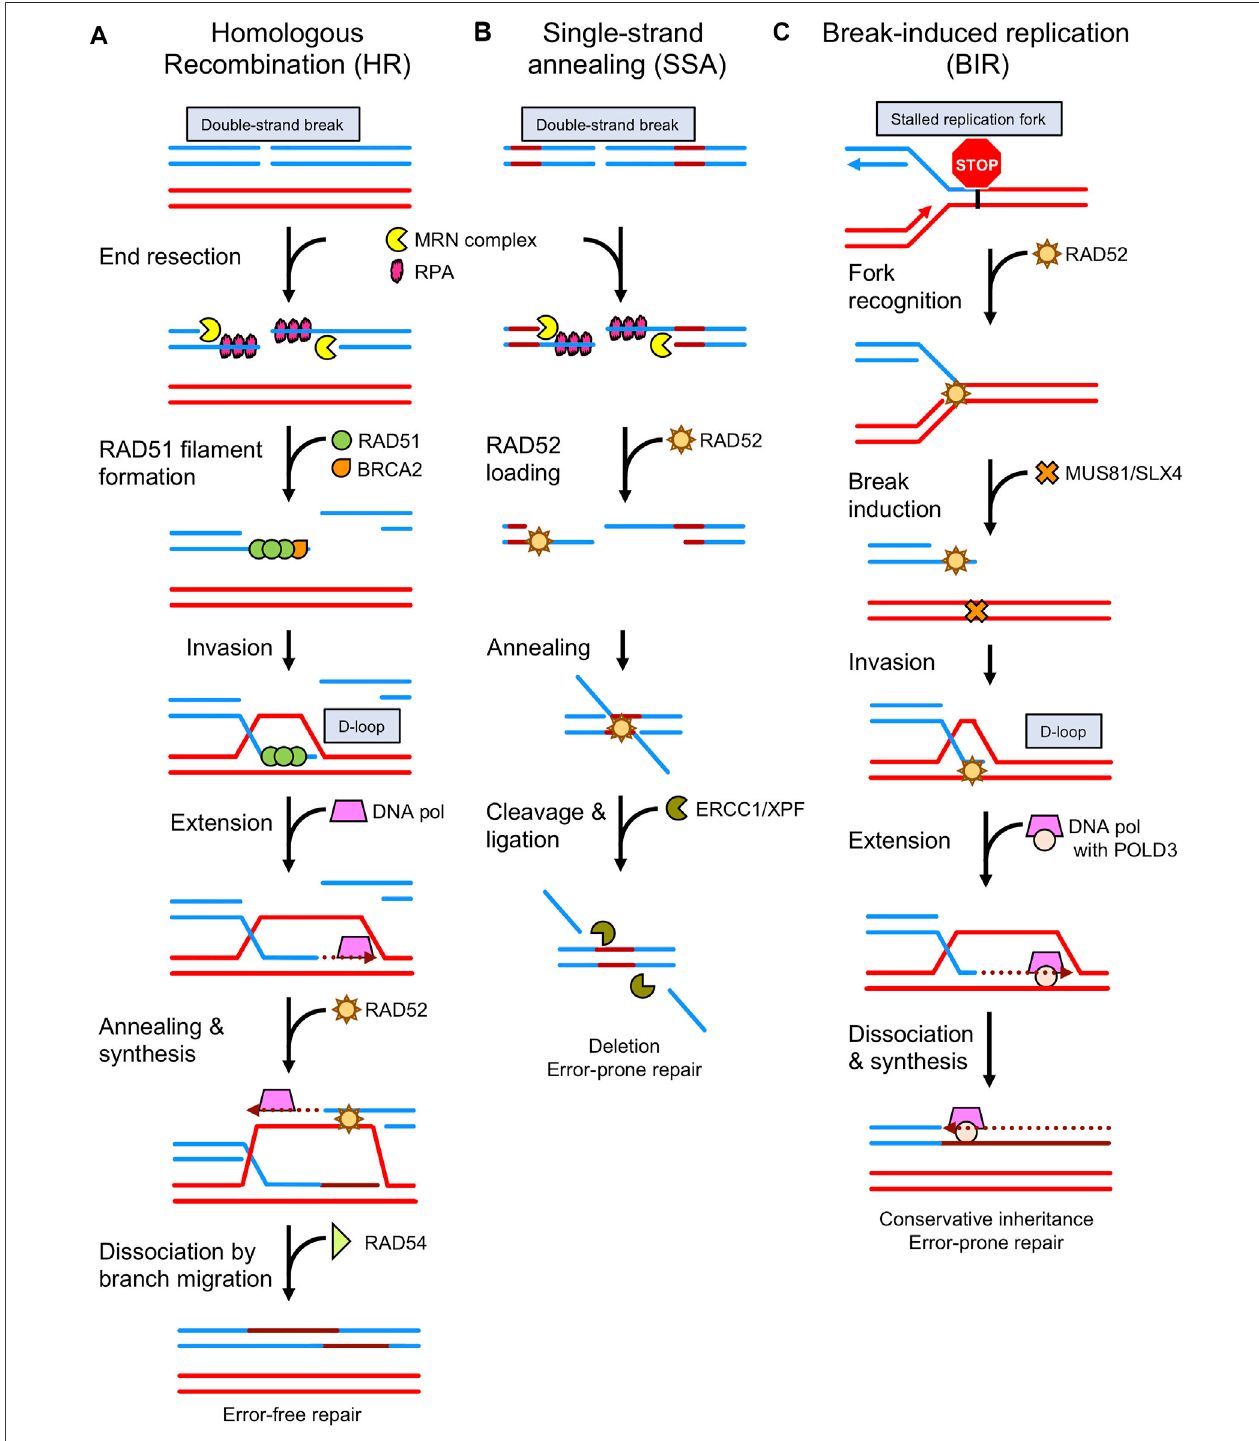
FIGURE 1 | Comparison of RAD51 and RAD52-mediated DNA repair pathways. (A) During homologous recombination (HR), the ends of the double strand break (DSB) are resected by nucleases (ex. MRN complex) [see (Zhao et al., 2020) for mechanism of action], exposing single-strand DNA (ssDNA) that becomes bound by RPA. Then the mediator protein, BRCA2initiates loading of RAD51 on ssDNA helping to displace RPA. RAD51 oligomerizes, forming a nucleoprotein fi lament, and then searches for the homologous DNA sequence on the intact chromosome. The RAD51 fi lament invades the intact dsDNA to form a D-loop structure. Further processingbyDNApolymerases,chromatinremodelers(ex.RAD54),nucleases,andligasesrestoretheintactDNAsequencethrougherror-freerepair. (B) Alternativeto HR, single strand annealing (SSA) begins after resection with the binding of RAD52 to ssDNA. RAD52 promotes the annealing of exposed homologous ssDNA regions